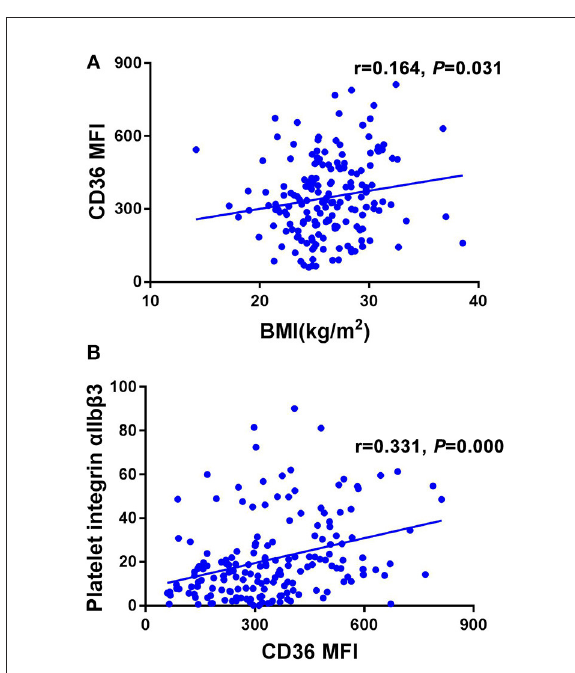
FIGURE2 The relationship between BMI, platelet CD36 and platelet activation. (A) BMI was positive correlated with platelet CD36 significantly (r = 0.164, P = 0.031). (B) Platelet CD36 was positively correlated with platelet activation biomarkers (platelet integrin α IIb β 3 ) (r = 0.331, P = 0.000).